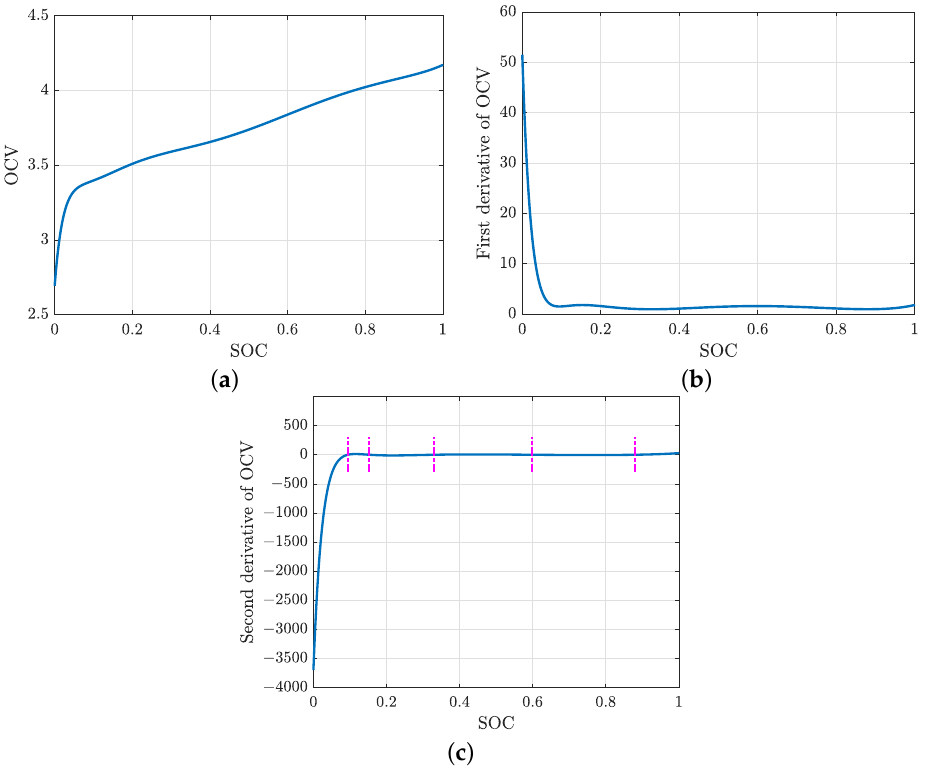
Figure 13. OCV model and its first two derivatives—( a ) OCV model- V ◦ ( s ) , ( b ) first derivative- V (cid:48) ◦ ( s ) , and ( c ) second derivative- V (cid:48)(cid:48) ◦ ( s )